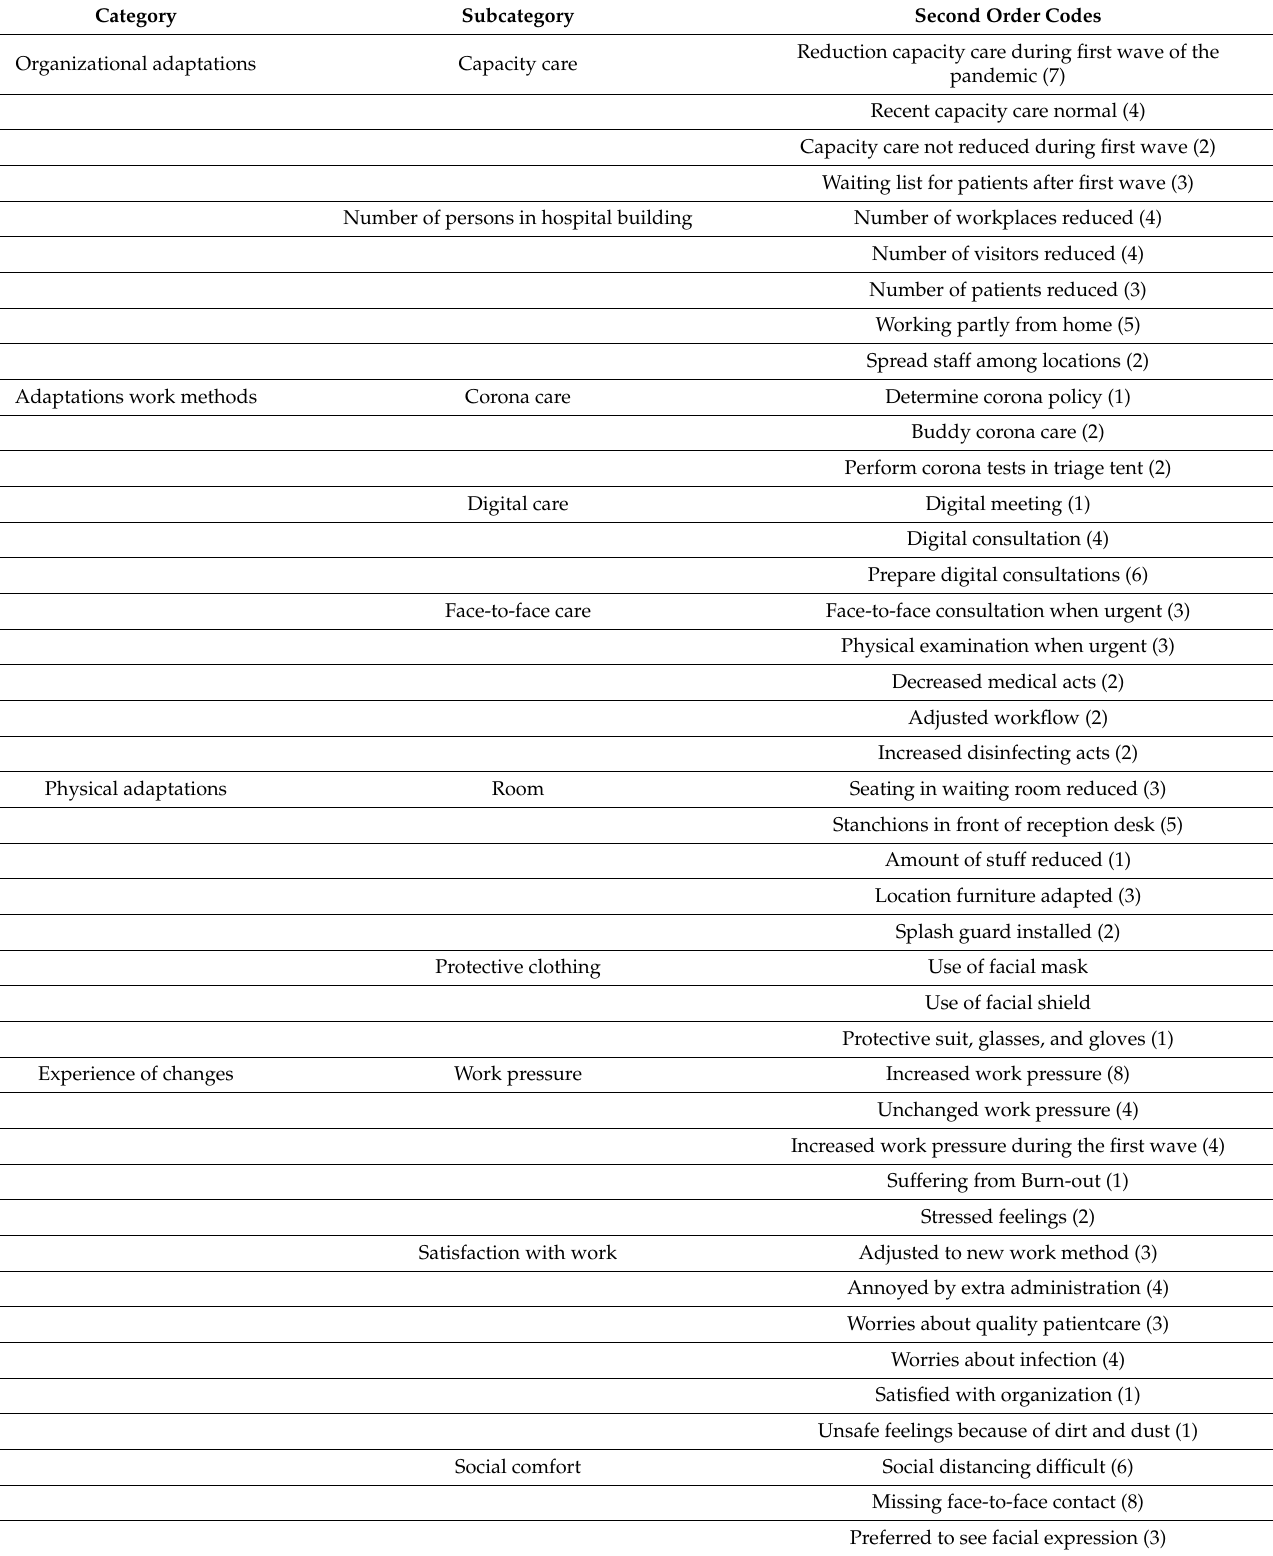
Table A1. Categories, subcategories, and second order